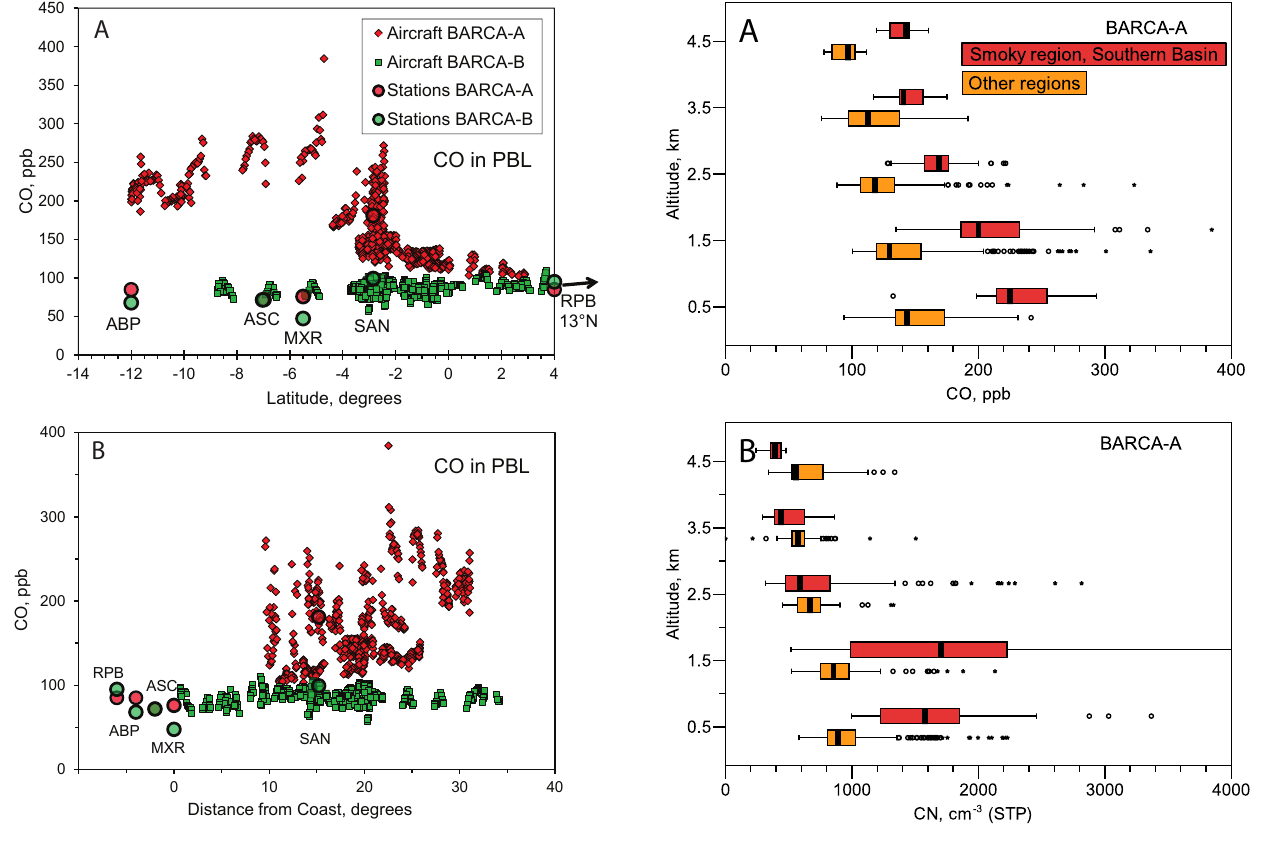
Fig. 6. Vertical profiles of CO mixing ratios (A) and CN number concentrations (B) during BARCA-A. The data from the smoky re- gion in the southern basin are shown separately. The center line in the bar-and-whisker plots represents the medians, the boxes show the upper and lower quartiles, the whiskers show the expected range, and the symbols represent outliers and extreme values (as defined by